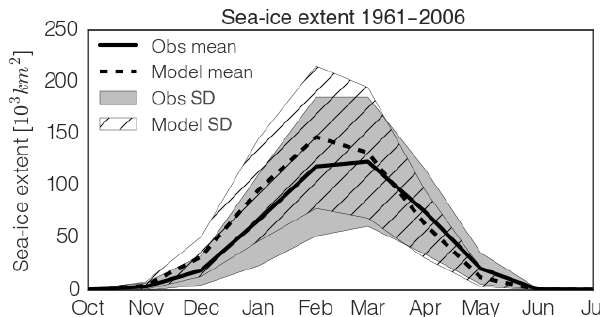
Figure 9. Seasonal cycles of simulated and observed total sea-ice extents in the Baltic Sea. The lines show the seasonal monthly means and the filled envelopes show the ± 1 standard deviations. The seasonal cycles are calculated for the periods 1961/1962– 2005/2006. Note that Skagerrak has been masked out in the obser- vational data